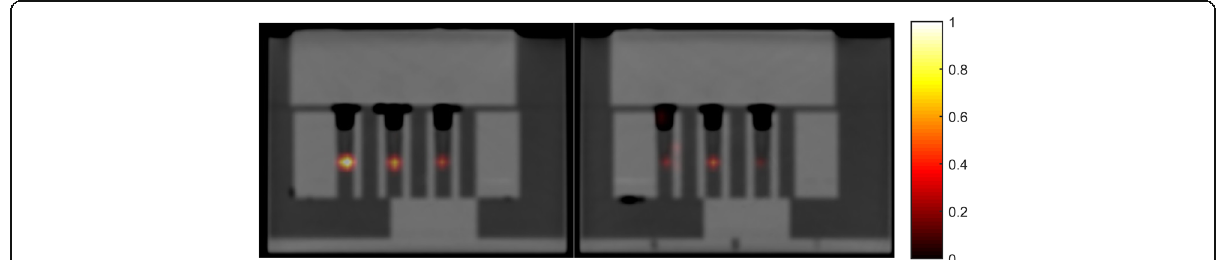
Fig. 3 Ga68-PSMA-11-PET/CT image of different Eppendorf tubes all containing a pellet with 2 × 10 5 HCT116+LNCaP cells. From left to right, the